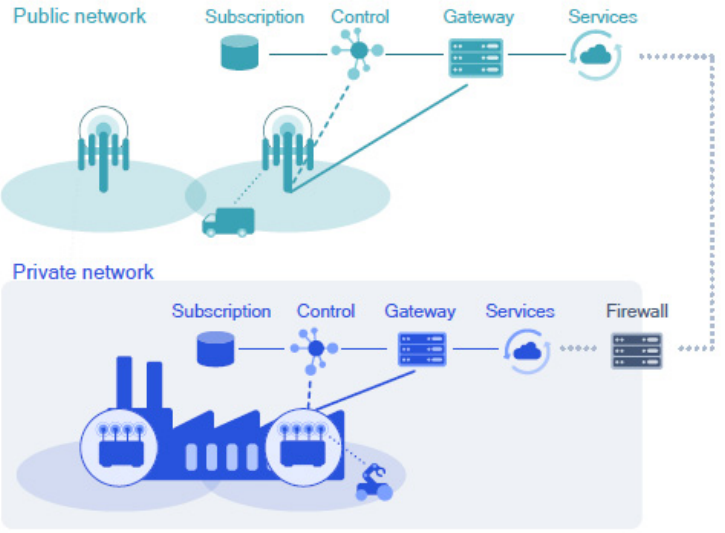
Figure 2 . 5G private